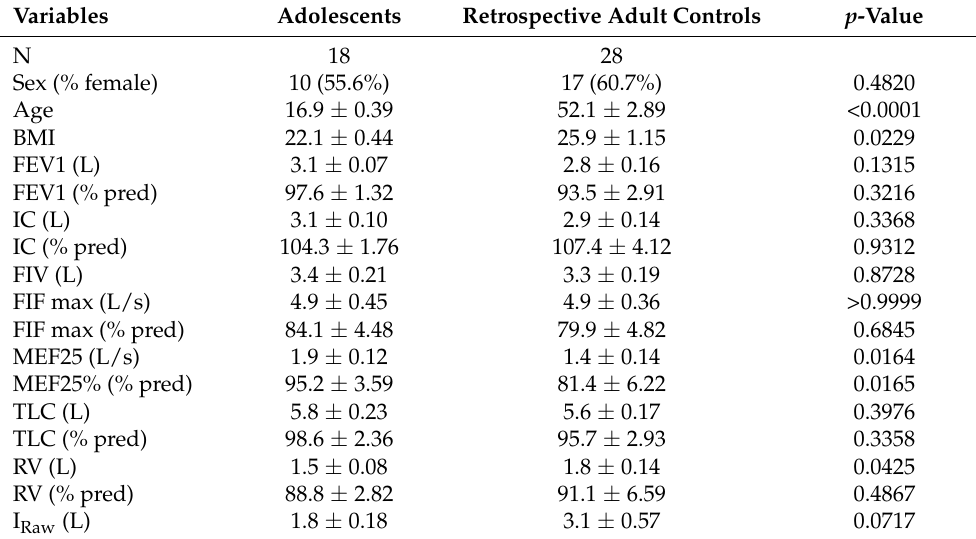
Table 1. Mean ± standard error of lung function parameters measured in the sample of adolescents and in the adult controls (absolute and relative frequency were used for the variable “sex”). Variables Adolescents Retrospective Adult Controls p -Value 28